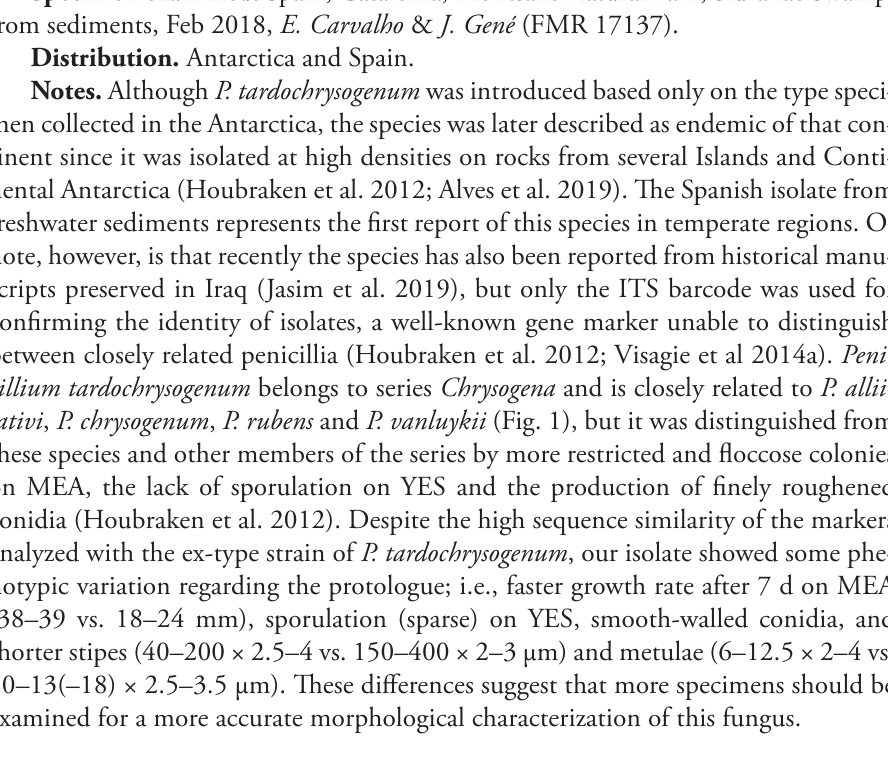
= Penicillium lacussarmientei Ramírez, Mycopathol. 96: 29. 1986. Type. Spain, Valladolid, San Miguel del Arroyo, from sandy soil under pine tree; J.A. Quintanilla ( holotype CBS H-148.83, cultures ex-type CBS 148.83, DTO 9E2, CECT